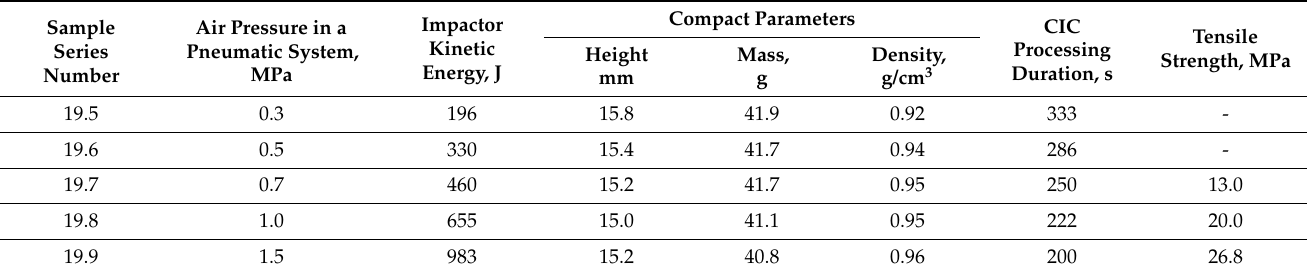
Table 1. Parameters of compacts made at different kinetic energy of the impactor.